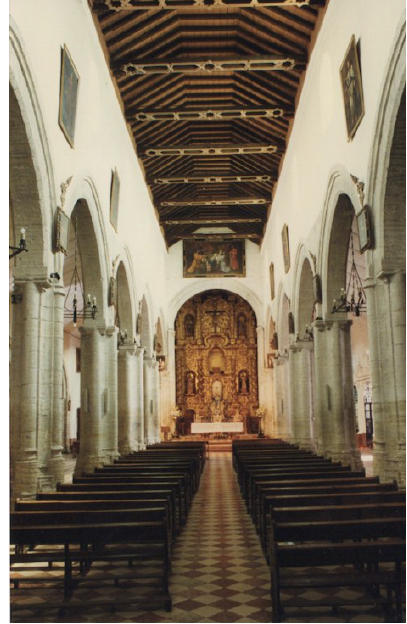
Figure 9. Parish church of Santa Maria del Soterraño. Aguilar de la Frontera (Cordoba). Photo took by author.